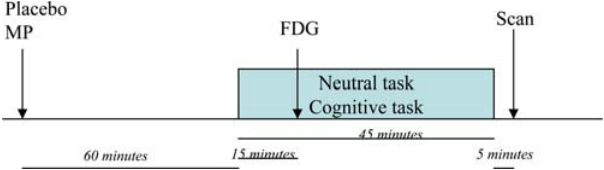
Figure 1. Schematic diagram of experimental procedure. Placebo (PL) or methylphenidate (MP) was given 60 minutes prior to initiation of Cognitive or Neutral tasks, which lasted 45 minutes. [ 18 F]FDG was injected 15 minutes after task initiation (75 minutes after MP or PL) and scans were started 35 minutes after injection.